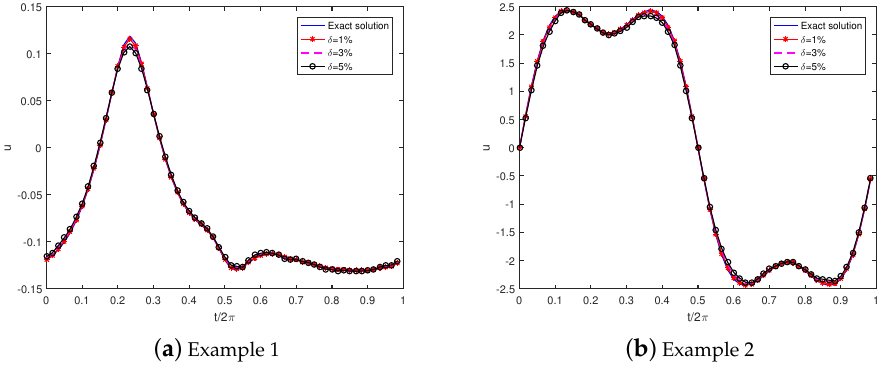
Figure 1. The numerical solutions with the percentages of noise increasing from 1% to 5% on ∂ D